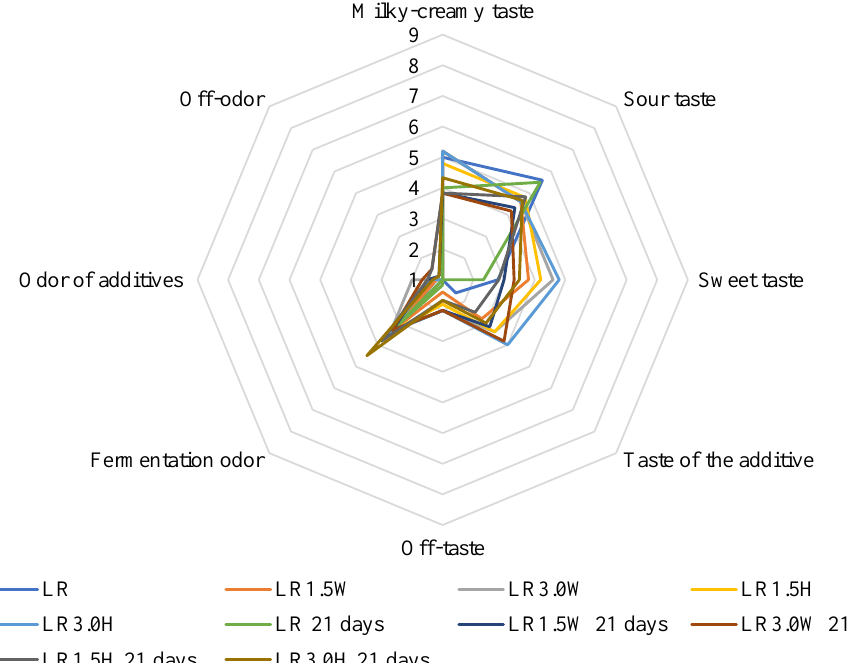
Figure 4. Effect of collagen addition on the organoleptic parameters of milk fermented by L. rhamnosus after 1 and 21 days of cold storage. LR—control milk with Lacticaseibacillus rhamnosus ; LR1.5W— milk with 1.5% collagen and Lacticaseibacillus rhamnosus ; LR3.0W—milk with 3.0% collagen and Lacticaseibacillus rhamnosus ; LR1.5H—milk with 1.5% collagen hydrolysate and Lacticaseibacillus rhamnosus ; LR3.0H—milk with 3.0% collagen hydrolysate and Lacticaseibacillus rhamnosus